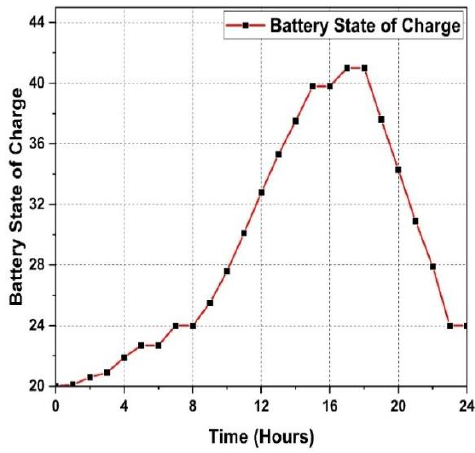
Figure 5. Battery states of charge (SoCs) in off−grid .